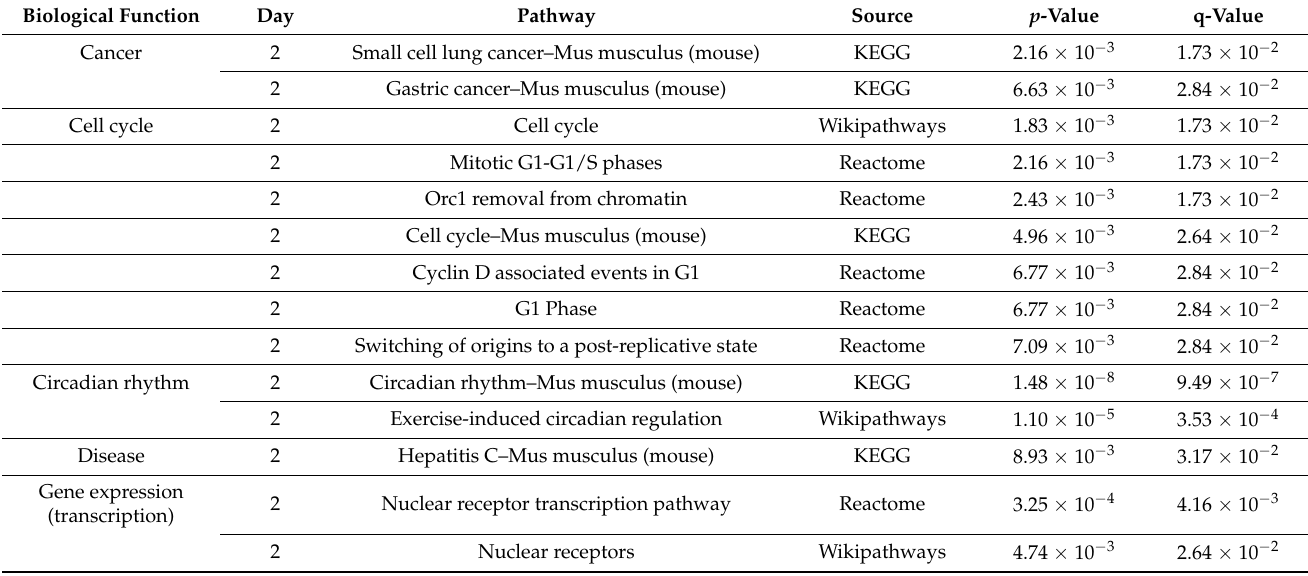
Table 3. Pathway over-representation analysis (ORA) of the 5% FDR-corrected DEGs following the exposure to 1 mg/kg bw /day of E171 (absolute FC ≥ 1.5, q-value < 0.05). Pathways were grouped by timepoint and biological